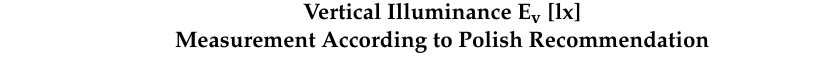
Table A5. Measurement results for the quality of illumination at pedestrian crossing no. 3 and cycle path—direction